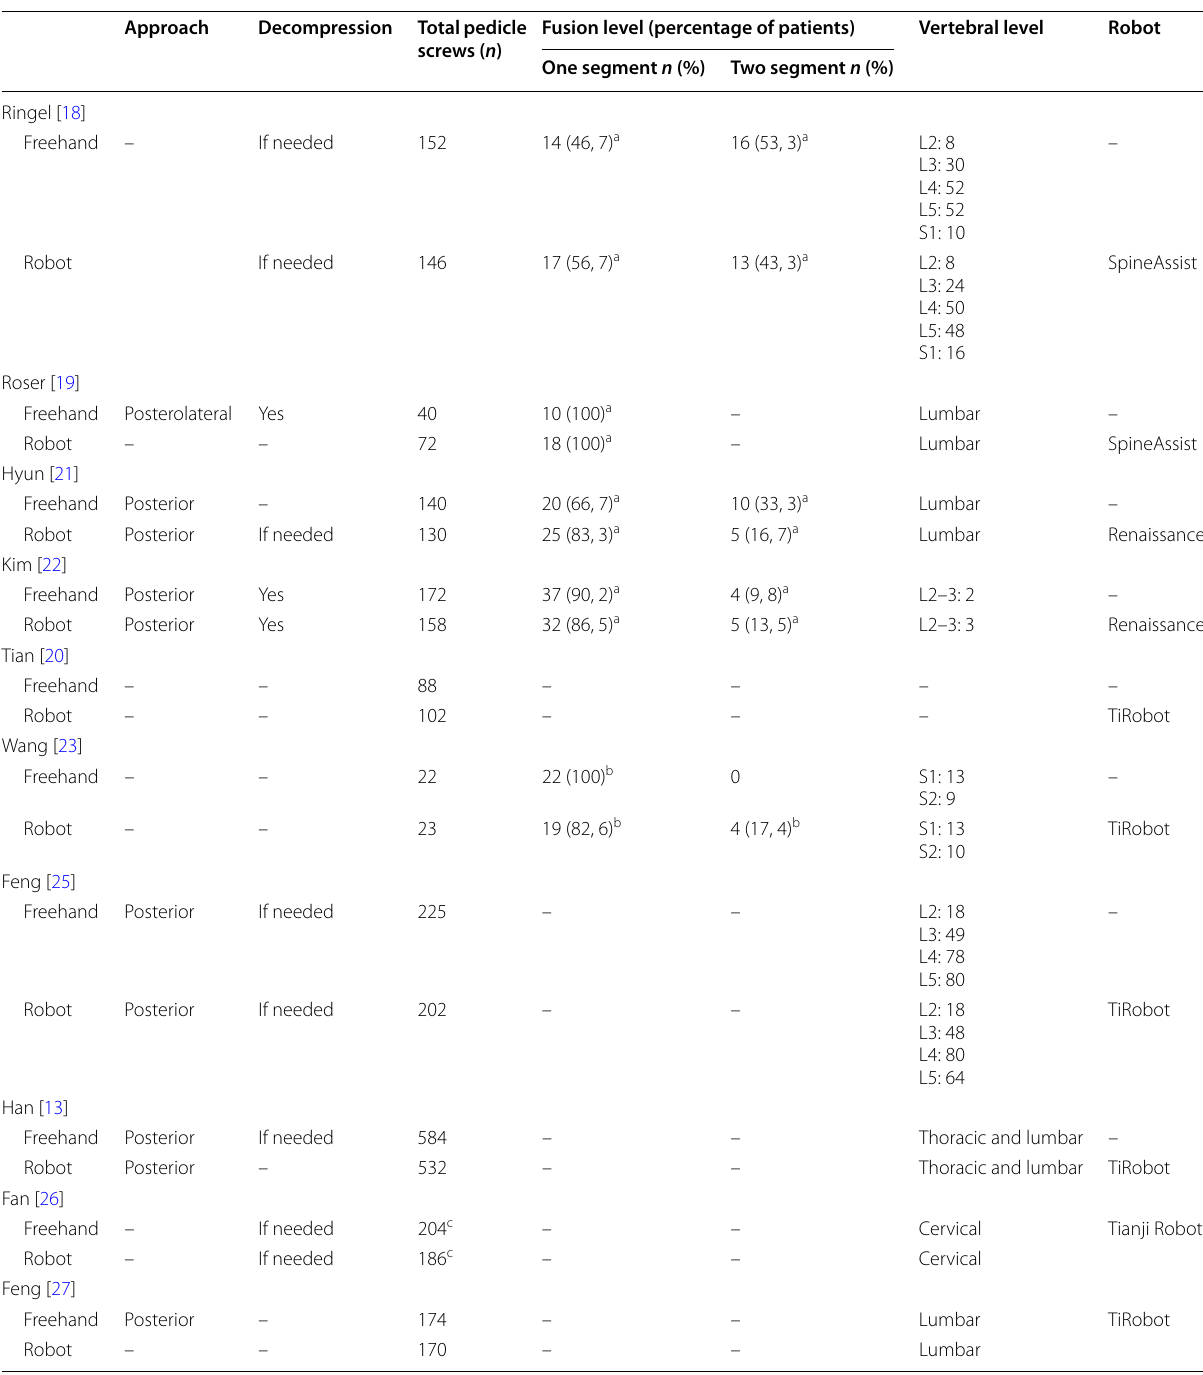
Table 3 Surgery